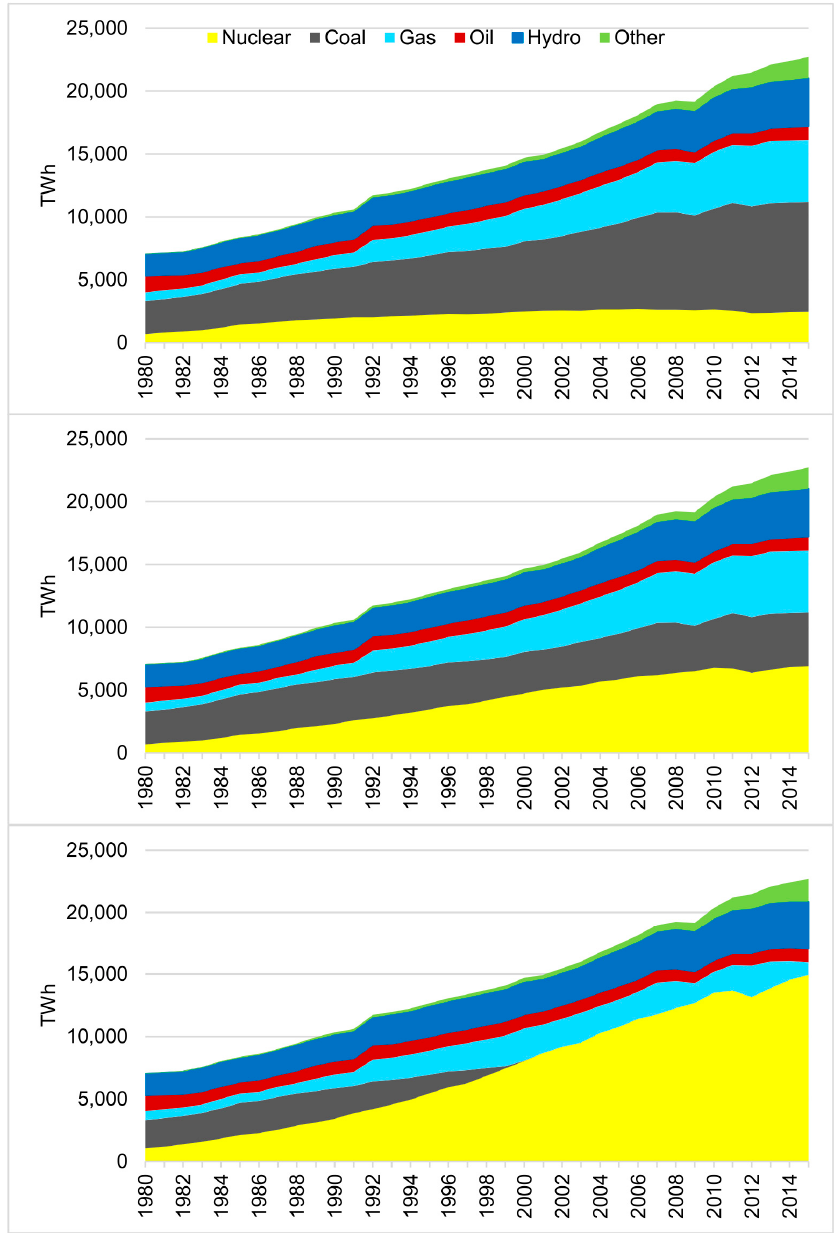
Figure 7. Electricity generated by fuel type by the Actual ( top ); and by the projected capacity in Linear ( middle ) and Accelerating ( bottom ) deployment scenarios (TWh). Table 4. The extra electricity that could have been generated by nuclear power, and the consequent deaths and CO 2 emissions that could have been avoided with the Linear and Accelerating deployment rate scenarios [XIII] .